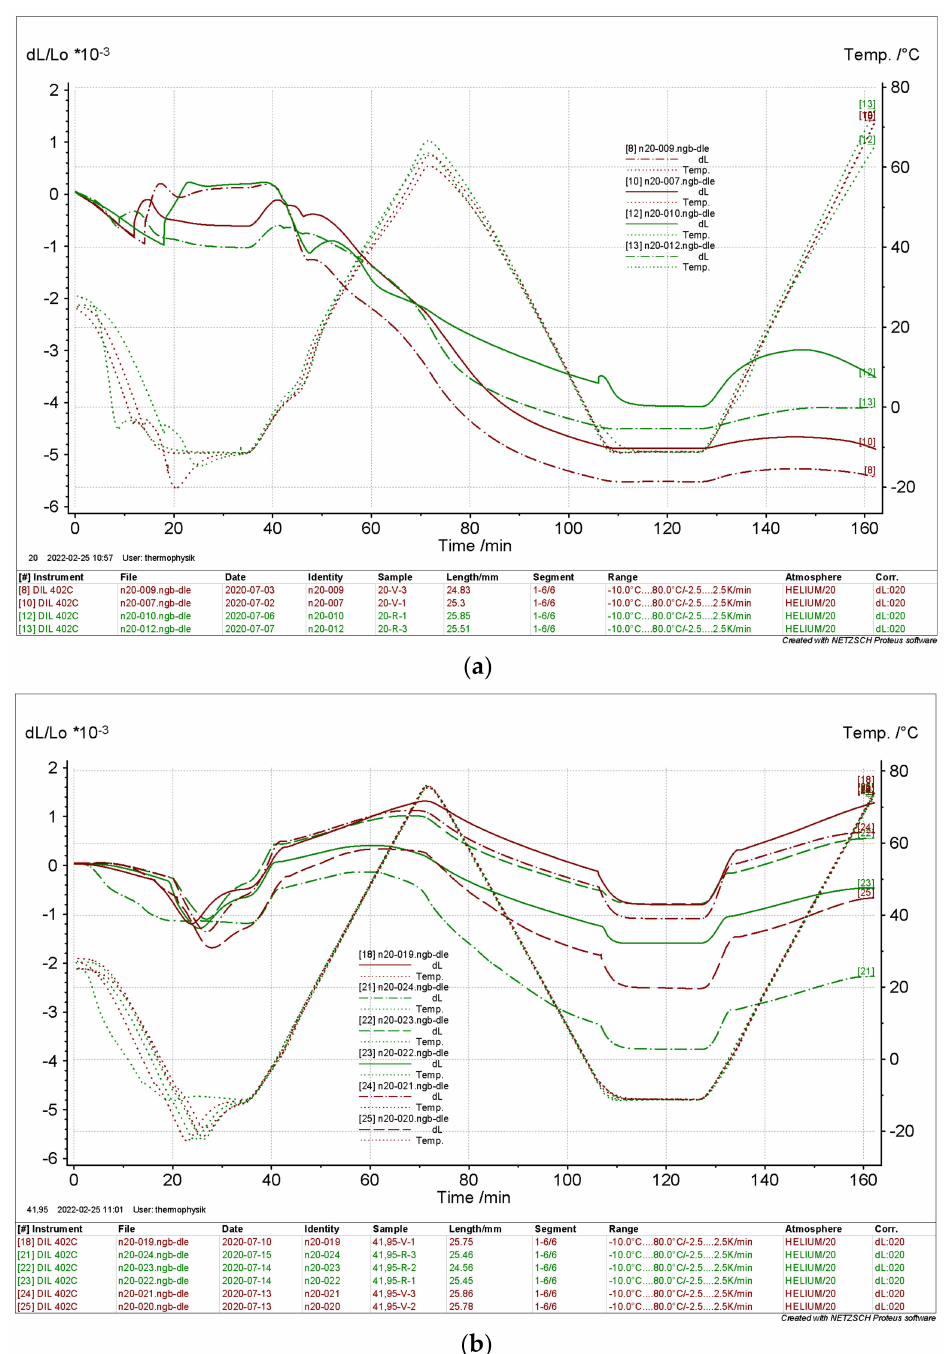
Figure 11. Results of the relative linear thermal expansion of the moist drill core samples from depths of ( a ) 20 m and ( b ) 41.95